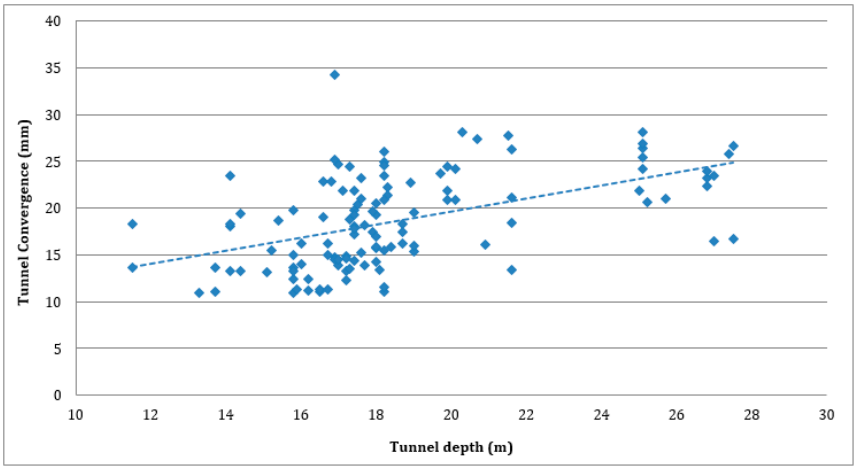
Figure 6. Relationship between tunnel depth and measured convergences in KUR project.